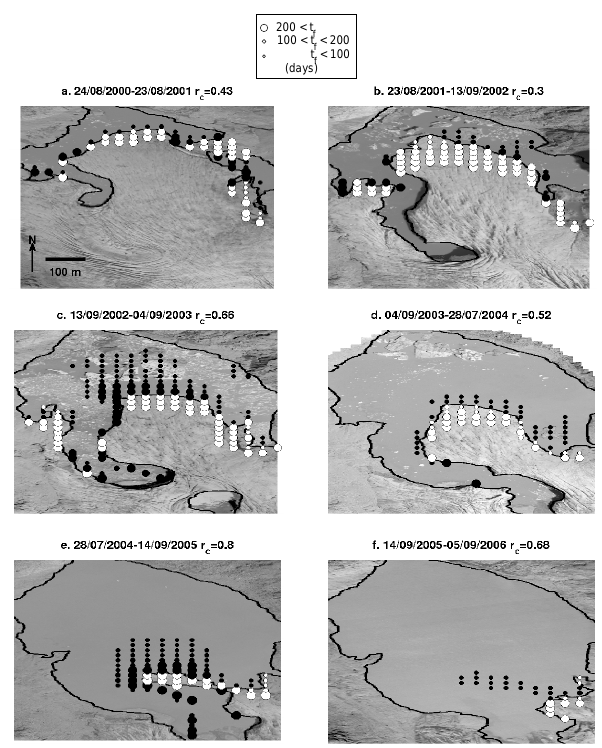
Fig. 9. Results of modelled glacier retreat from 2000 to 2006; cir- cles denote points likely to calve, black circles denote points which calved, white circles denote points where ice is still present at the end of the considered time interval; t f indicates the time a point requires to reach flotation level; r c is the flotation model relevance.